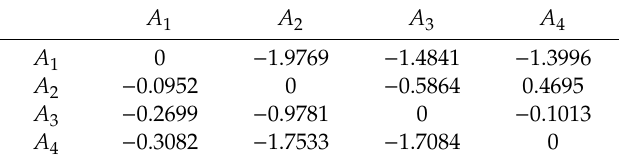
Table 8. Dominance degree of judgment debtor A i over judgment debtor A k